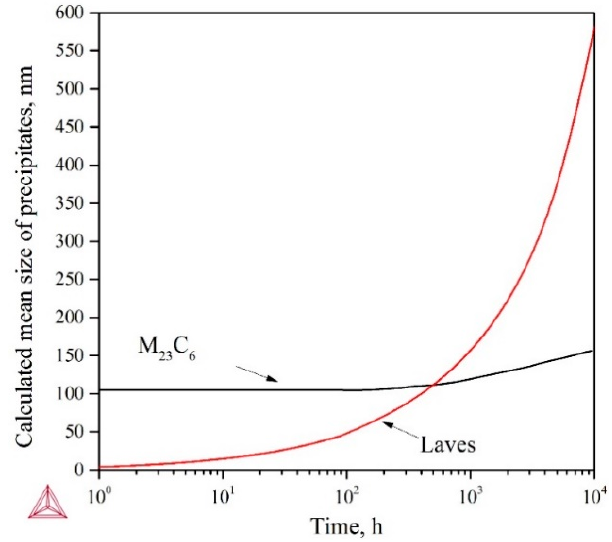
Figure 15. Precipitation kinetic of two precipitates in 9Cr-3W-3Co steel under 650 °C simulated by Thermo-Calc.